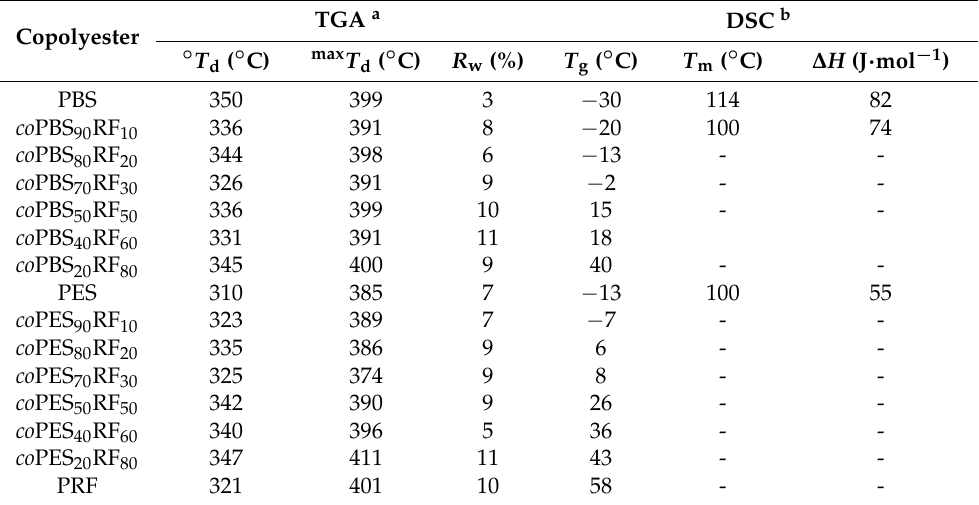
Table 3. Thermal Properties of co PBS x RF y and co PES x RF y